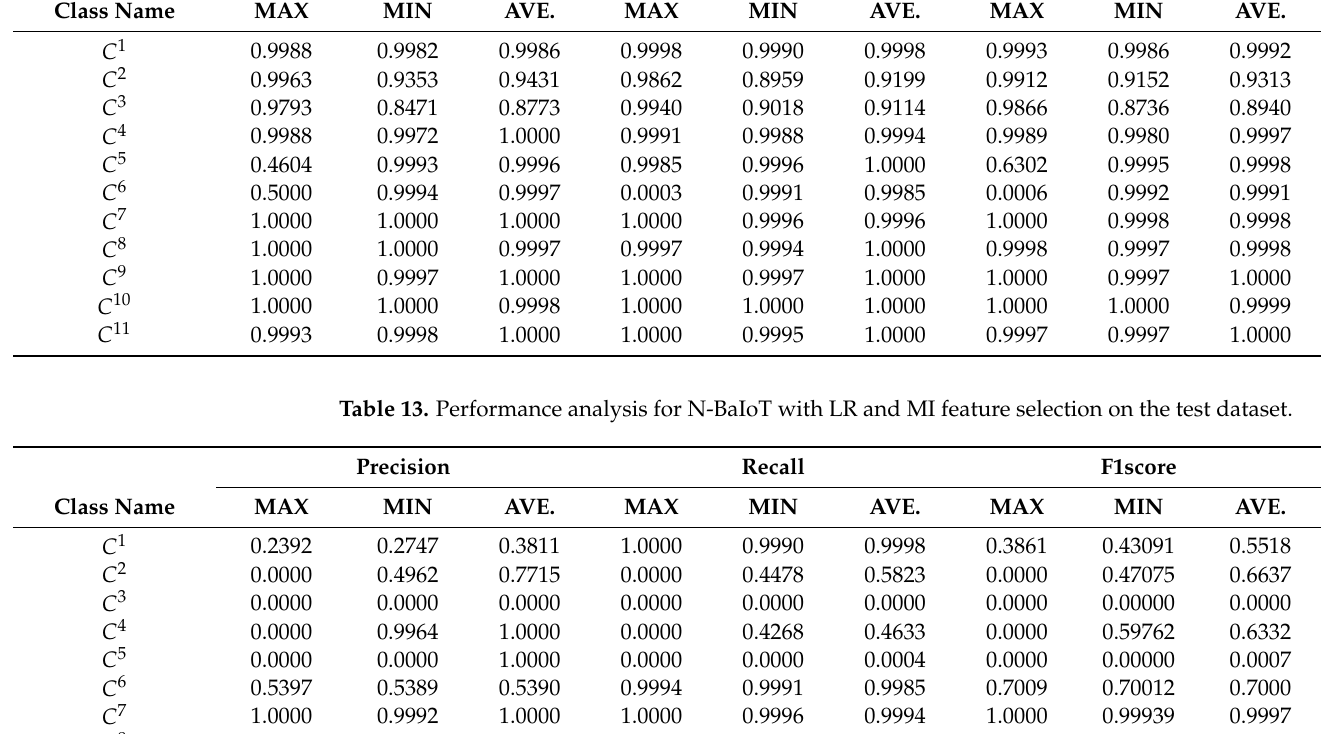
Table 12. Performance analysis for N-BaIoT with k-NN and MI feature selection on the test dataset. Precision